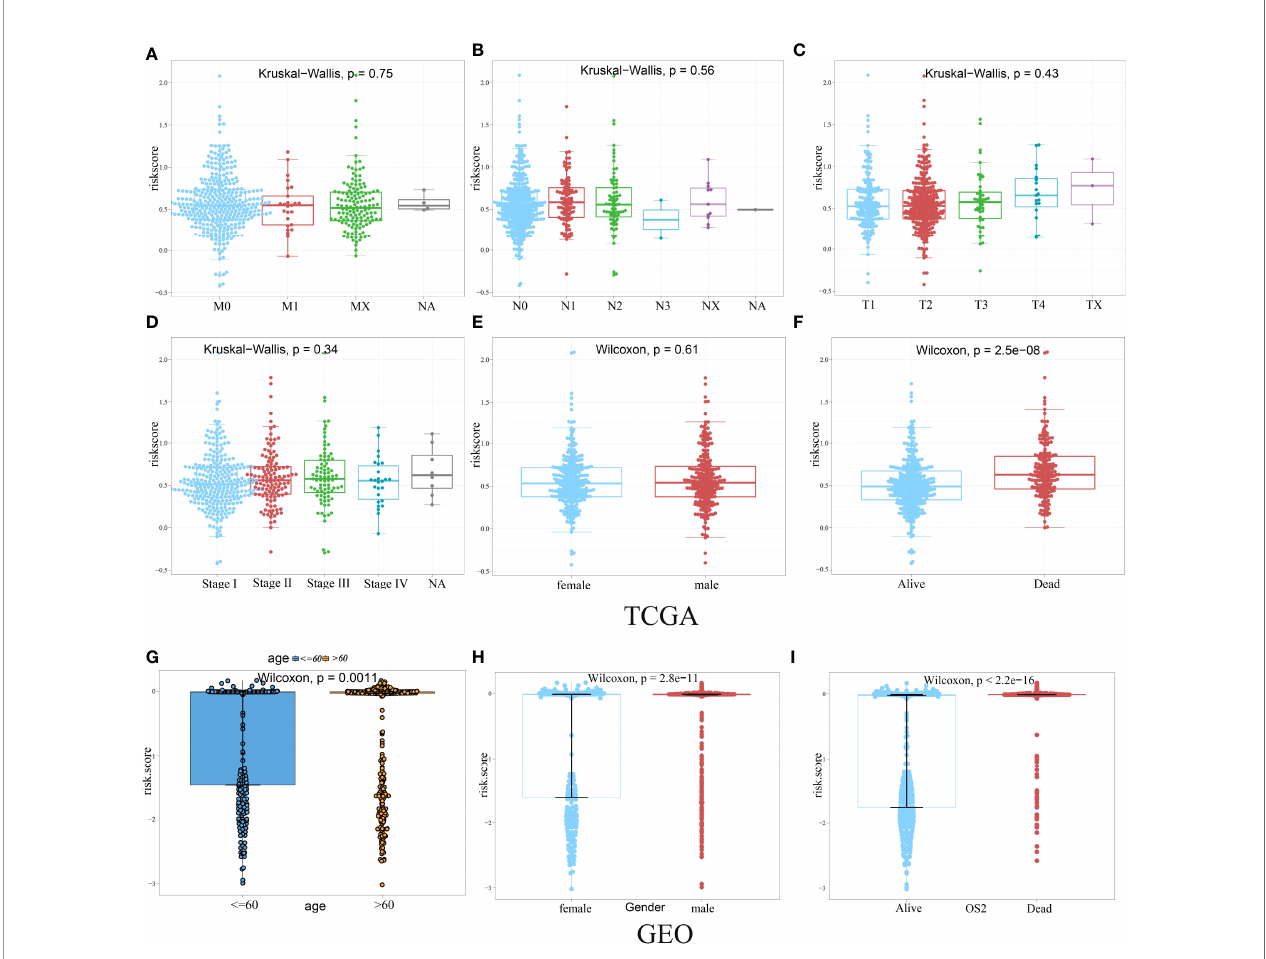
FIGURE 6 | Difference analysis of the distribution of HAGS risk score in different TNM stage (A – D) , age (G) , gender (E, H) , and survival status (F, I) . Statistical difference of three or more groups was compared by the Kruskal – Wallis test and that of two groups was compared by the Wilcoxon